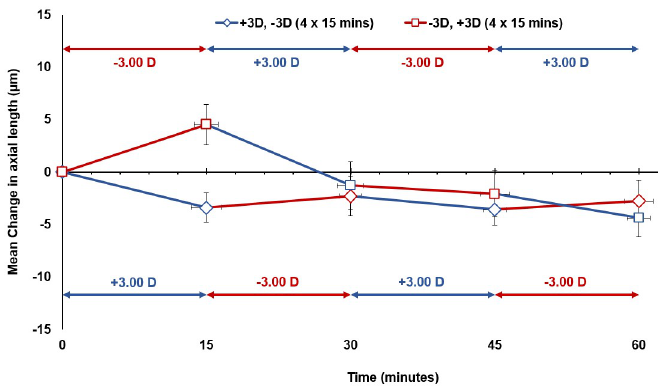
Fig 5. The mean change in axial length from baseline (0 minute time point) during 15 minute alternating cycles of hyperopic then myopic defocus (Condition E), and myopic then hyperopic defocus (Condition F) for all subjects. Vertical error bars represent the standard error of the mean difference in axial length, and horizontal error bars represent the standard error in measurement time. Asterisks indicate a significant mean difference from the baseline axial length (p <